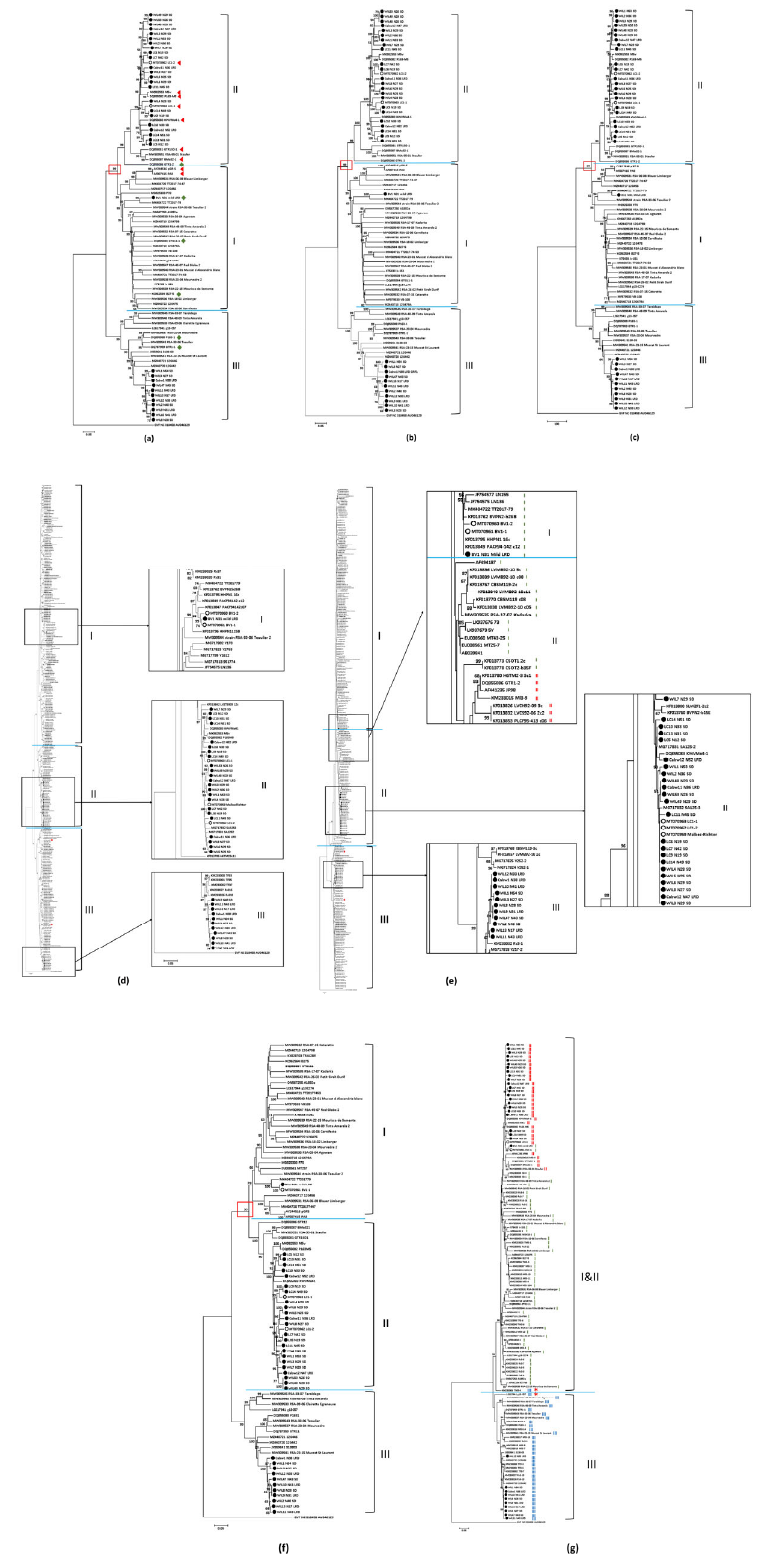
Figure 2. Neighbour-joining phylogenetic analysis of grapevine virus A (GVA) using 35 metagenomic sequences and all available sequences from GenBank. A neighbour-joining tree using ( a ) complete genome sequences alignment above 6991 nts, (GVA isolates associated with SD-affected grapevines are labelled with red triangles and isolates associated with asymptomatic grapevines are labelled